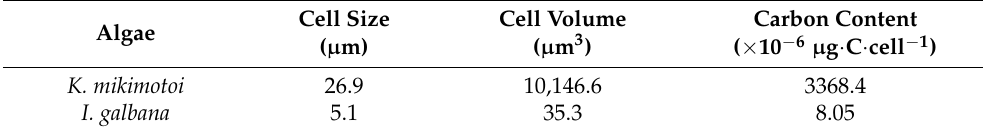
Table 2. Algae characteristic parameters used in the experiment.